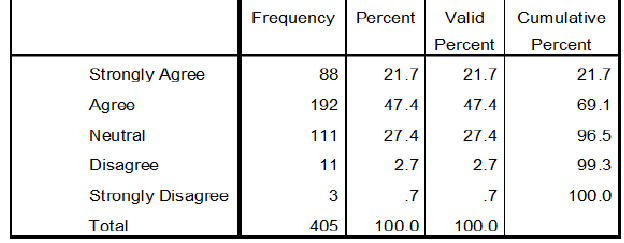
Figure 49. We receive positive and